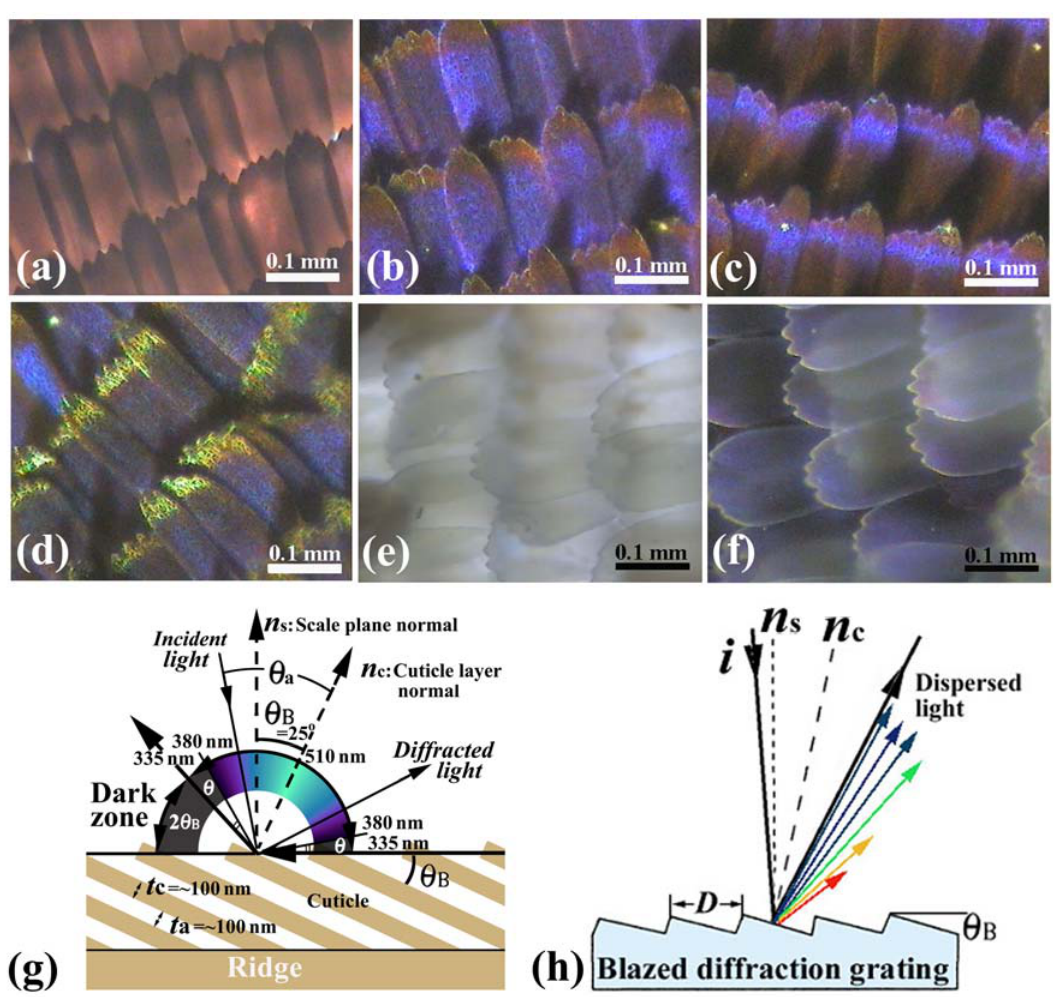
taken at different incident angles of white light. Transmission image ( a ) and reflection images of B scales ( b – d ); Transmission image ( e ) and reflection image of W scales ( f ); ( g ) Schematic illustration of the selective reflection from cuticle layers piled on the ridge; ( h ) Schematic illustration of a blazed diffraction grating (adapted from